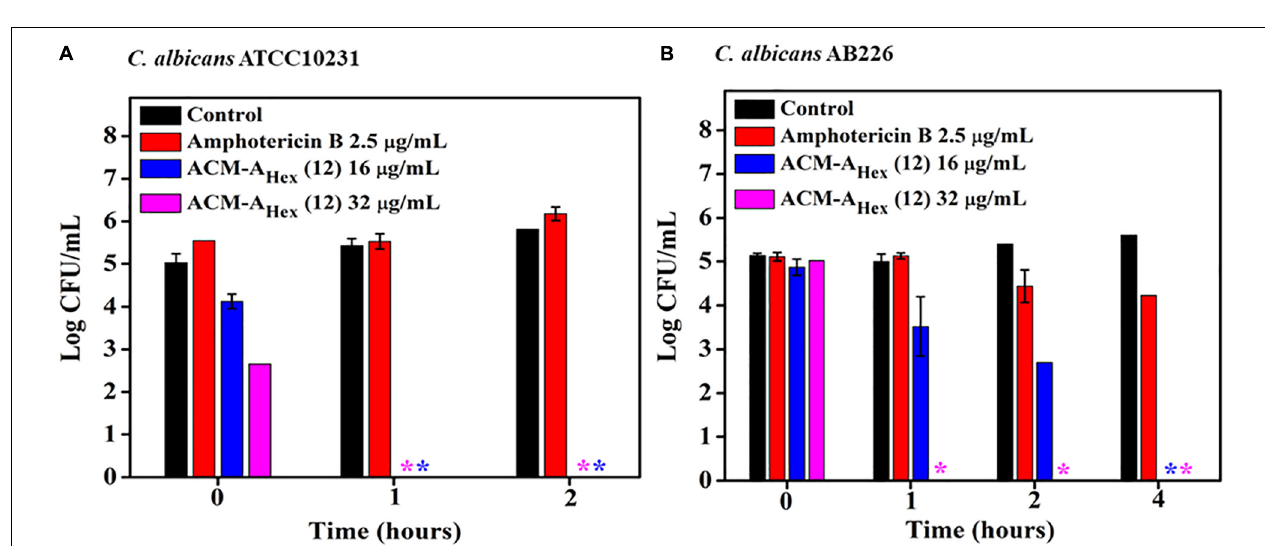
FIGURE 3 | Time kill kinetics of ACM-A Hex ( 12 ) against (A) stationary phase MRSA ATCC33591; (B) stationary phase MRSA R3545; (C) persisters of S. aureus MTCC737; (D) stationary phase E. faecium ATCC19634; (E) stationary phase VRE909. (Asterisks corresponds to < 50 CFU/mL). Each value represents average of four different values and error bar indicates standard deviation ( p < 0.0001, two-way ANOVA).